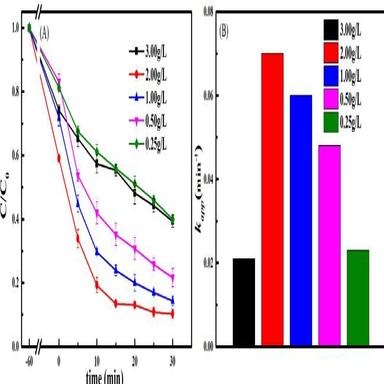
Effect of catalyst dosage on the sonocatalytic degradation of RhB (A) and the corresponding Kapp values (B).